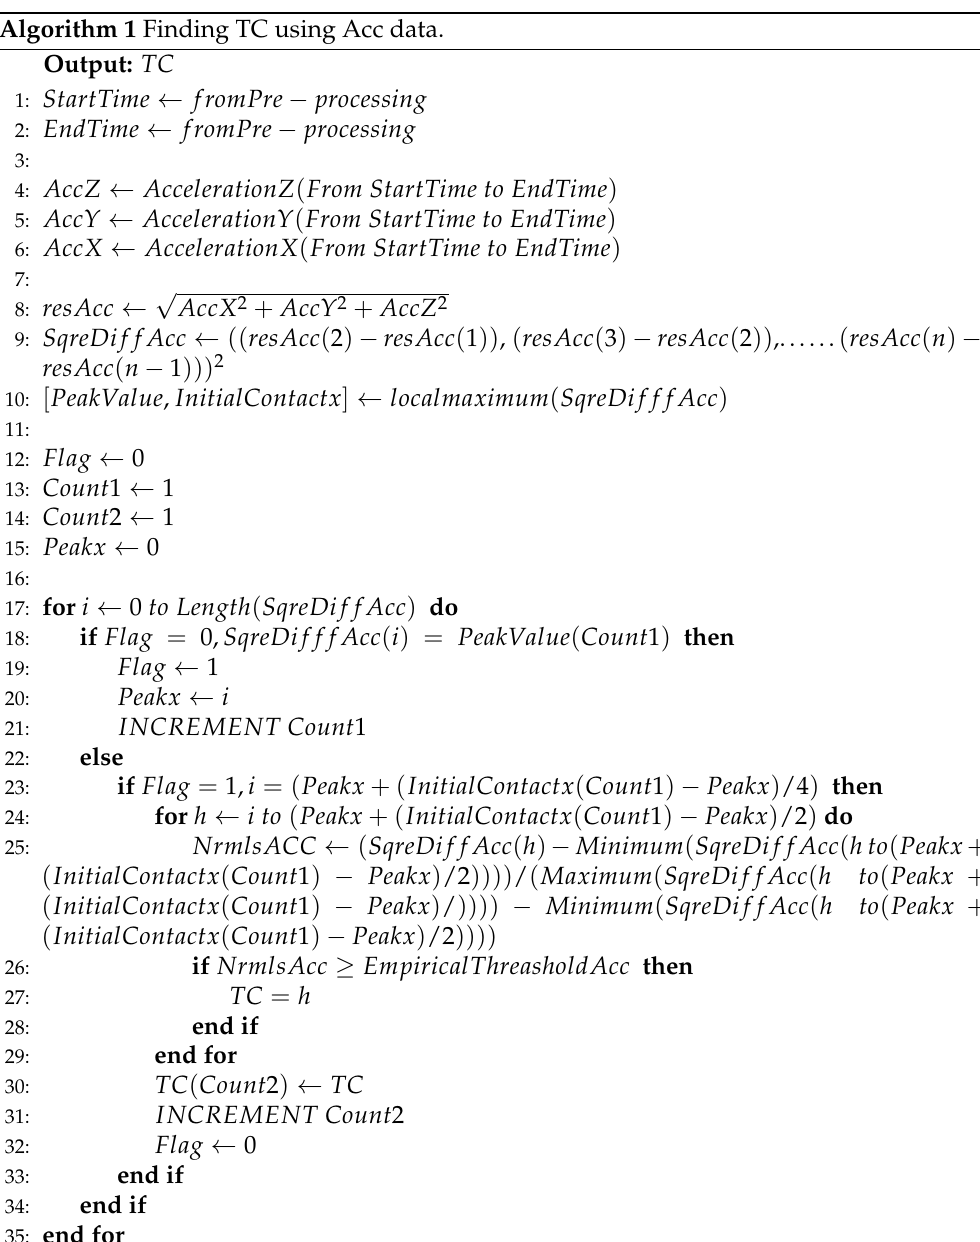
Algorithm 1 Finding TC using Acc